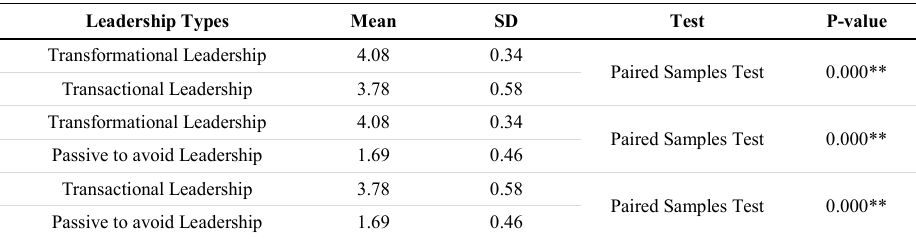
Table 3. Leadership Types Differences.